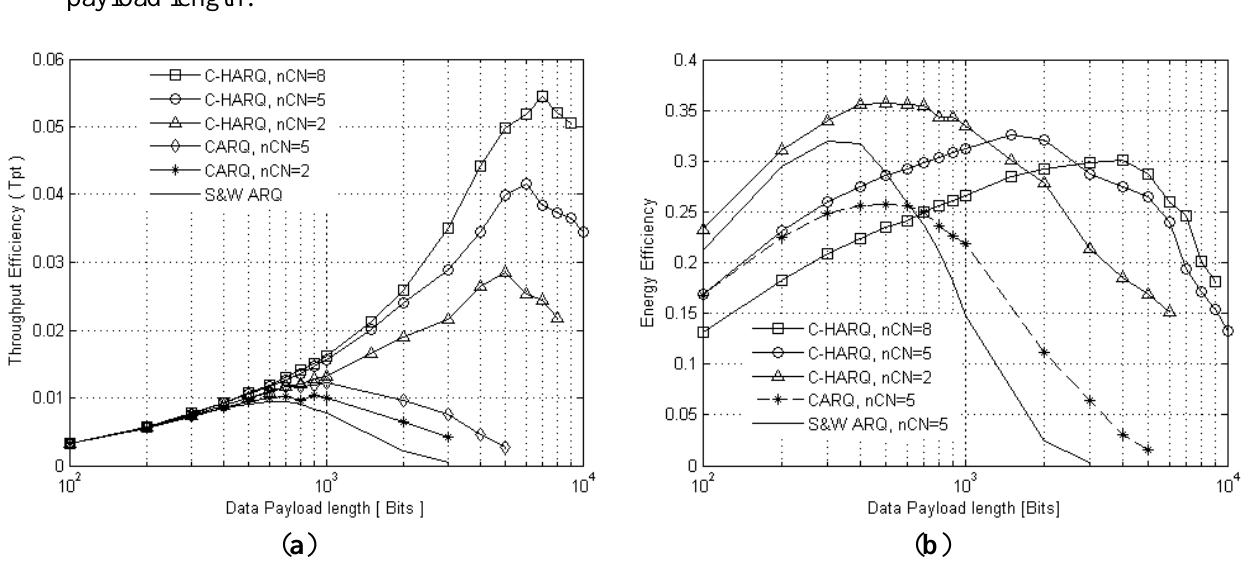
Figure 4. ( a ) Throughput efficiency vs. data payload length; ( b ) Energy efficiency vs. data payload